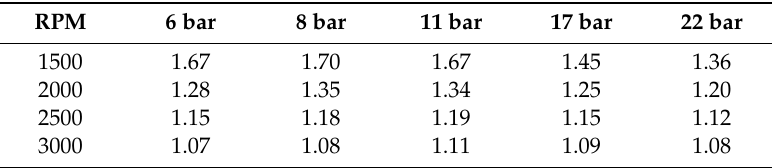
Table 2. ε as a function of ICE speed and mean e ff ective